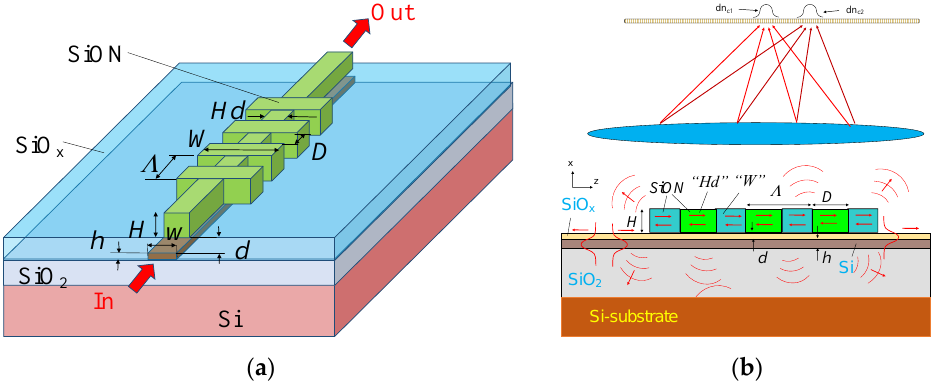
Figure 1. The scheme of the optical sensor based on the interaction of the guided wave with the virtual leaky wave of the segmented grating. ( a ) General view of segmented structure; ( b ) general arrangement of far field interrogation: optical waves corresponding to the different index increments (dn c1 and dn c2 ) were focused at different positions on the photodetector screen.